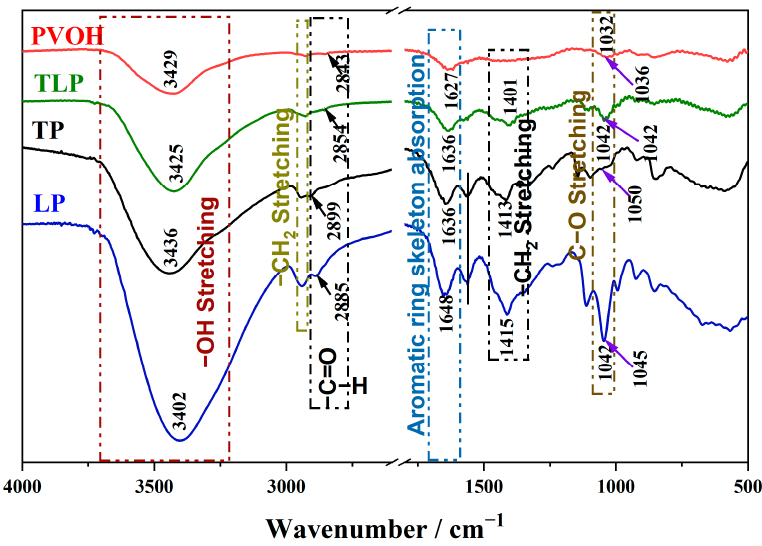
Figure 1. FT-IR spectra of PVOH, tannin-PVOH (TP), lignin-PVOH (LP) and tannin-lignin-PVOH (TLP) films.